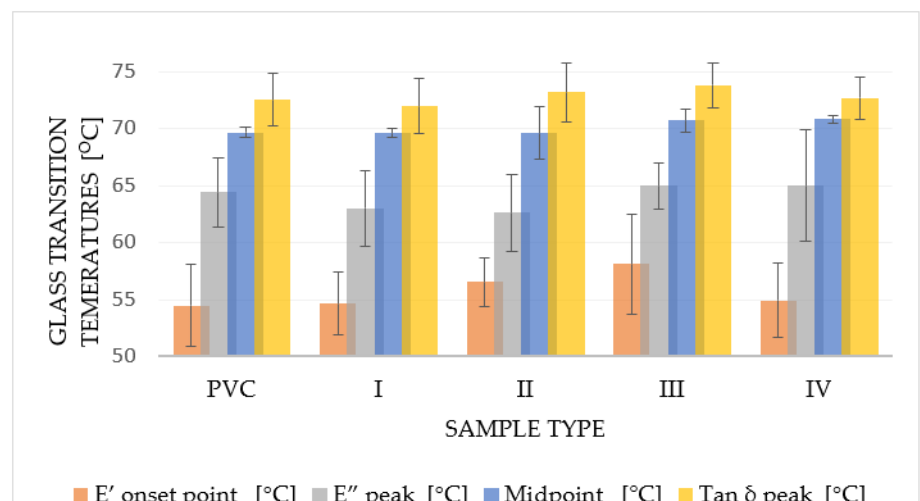
Figure 18. Determined Tan Delta curves of PVC samples, I, II, III, IV. The average change in the glass transition temperature for the plasma modified PVC polymer film was an increase of 1.6 ◦ C for the E (cid:48) , a decrease of 0.5 ◦ C for the E (cid:48)(cid:48) and an